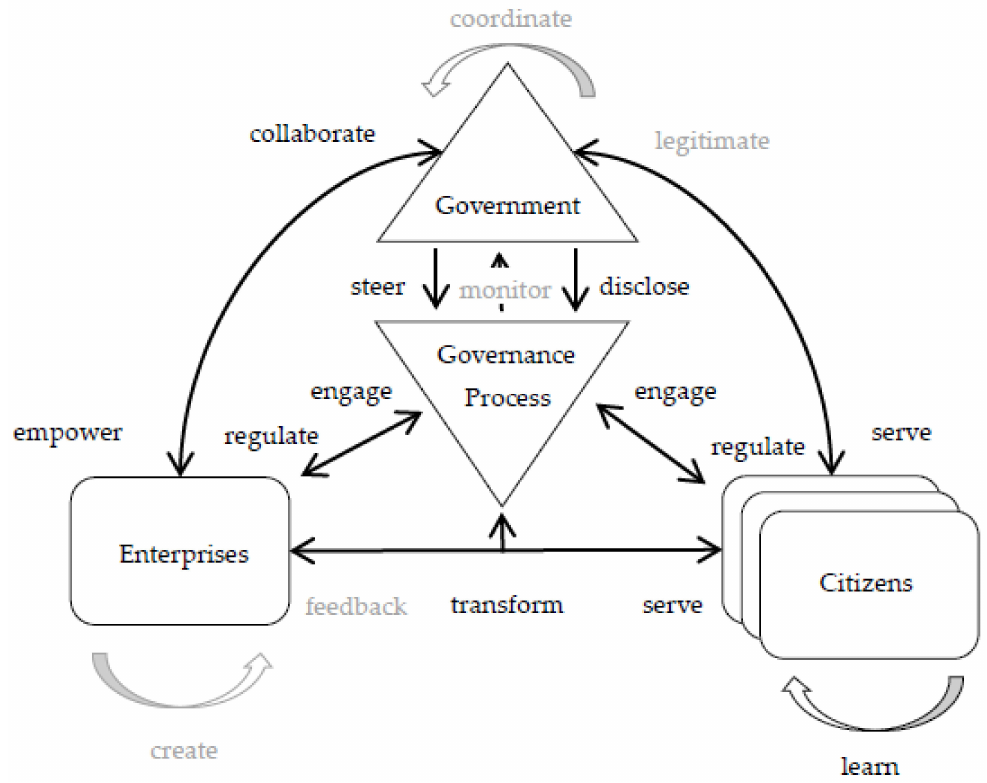
Figure 2. Framework instantiation, China State Council App project